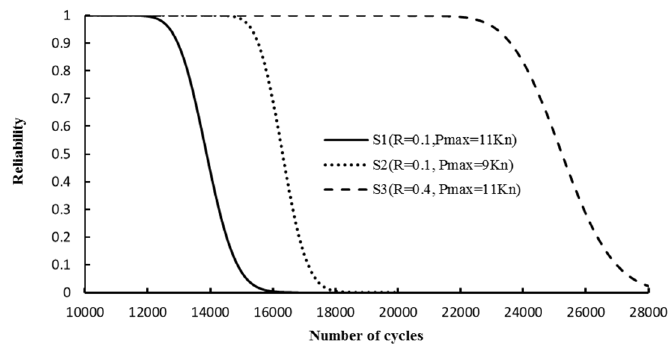
Figure 7. Reliability function of the investigated specimens.